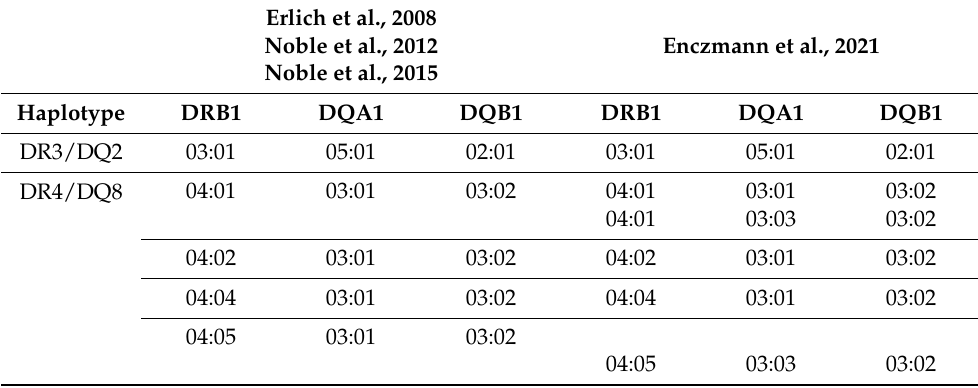
Table 1. HLA class II high risk haplotypes formerly described and found in our